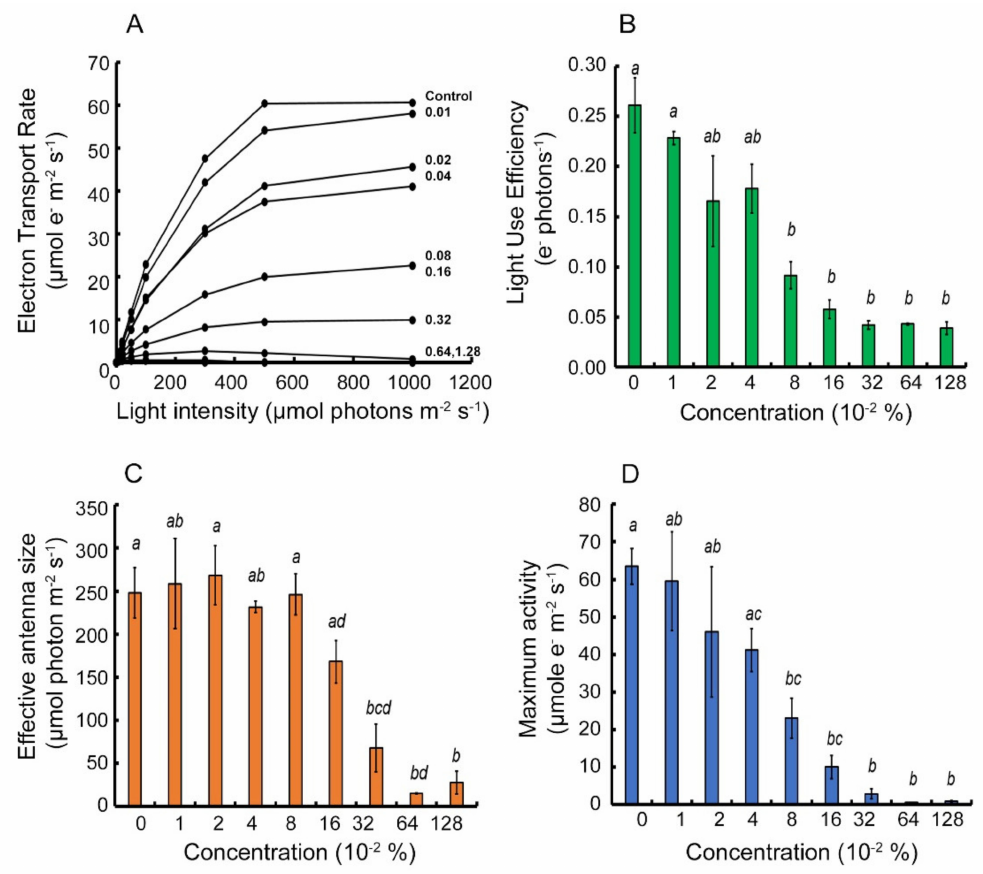
Figure 1. Parameterization of light response curves of Apple ( Malus domestica ) cultivar “Golden Delicious” that experienced a Brevis ® inhibitor gradient for 2 days under laboratory conditions. Panel ( A ) represents light response curves data. Panels ( B – D ) represent the parametrization variables-Light Use Efficiency (LUE) (green), Effective antenna size (orange), and maximum Electron Transport Rate (ETR) (blue), respectively. Each column is an average of three biological repeats. Error bars represent standard error of the mean. Amount of inhibitor is given in percentage. Letter notations describe statistically significant difference at p <